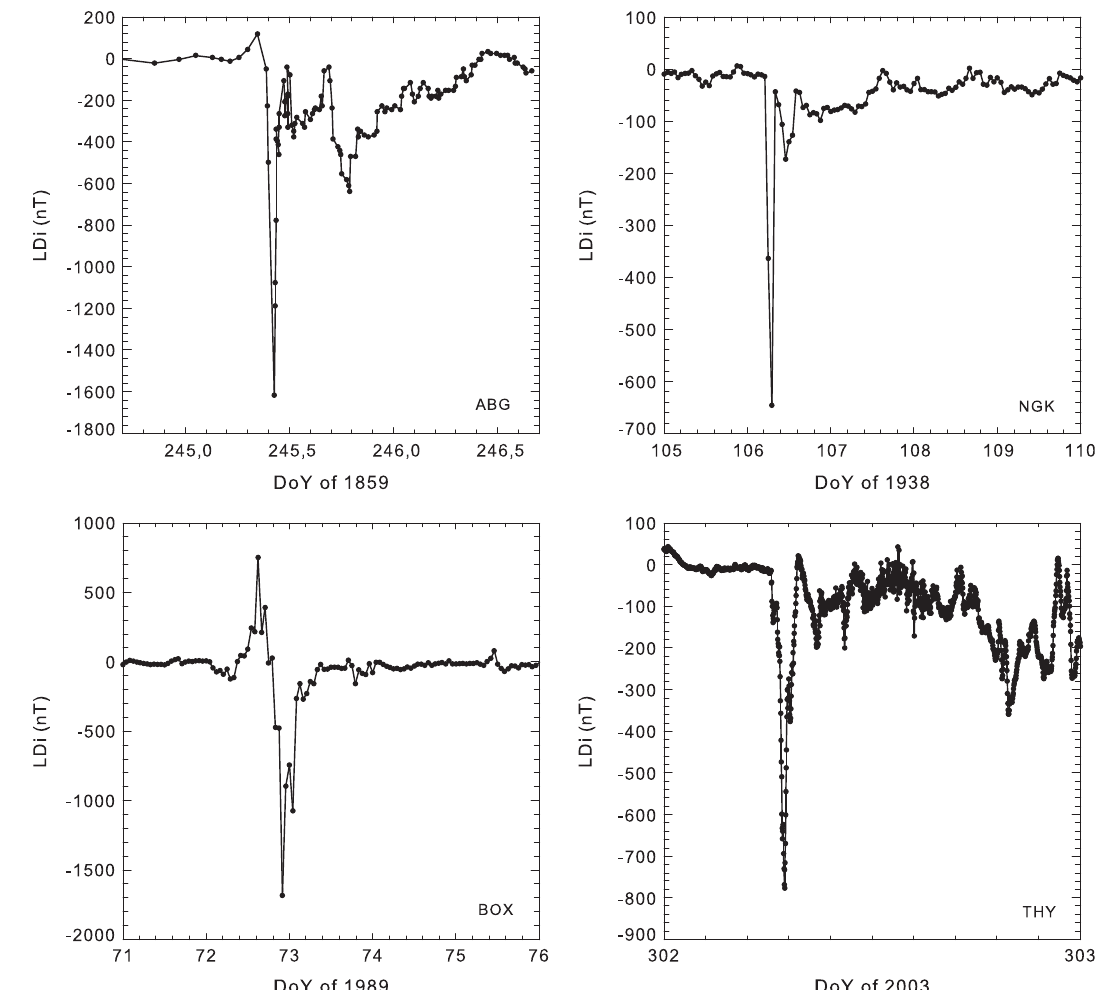
Fig. 4. The computed LDi for the events on September 1859 at ABG, April 1938 at NGK, March 1989 at BOX and October 2003 at THY, from left to right and top to bottom.